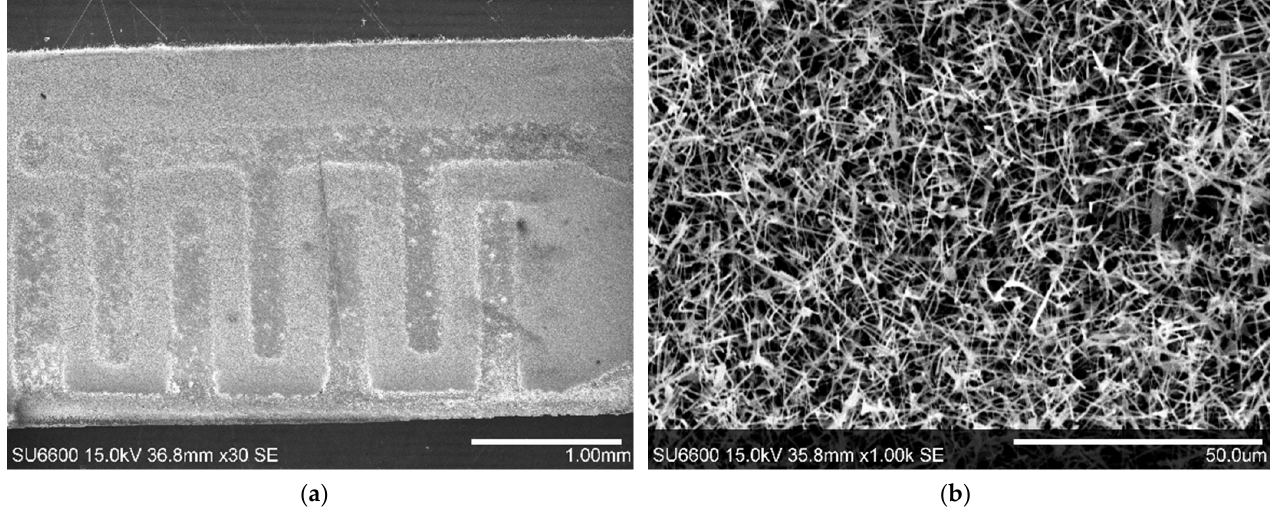
Figure 3. ( a ) SEM image of the top surface of the substrate with gold interdigitated electrodes and β -Ga 2 O 3 nanowires; ( b ) ×1000 magnified image of β -Ga 2 O 3 nanowires grown on the surface of Au electrode.